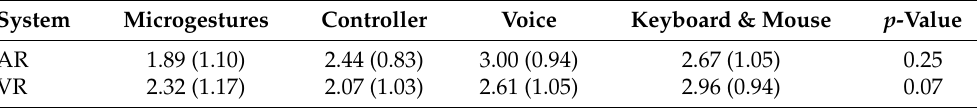
Table A3. The mean ( SD ) rank of four interaction methods for VR and AR systems across 40 partici- pants,